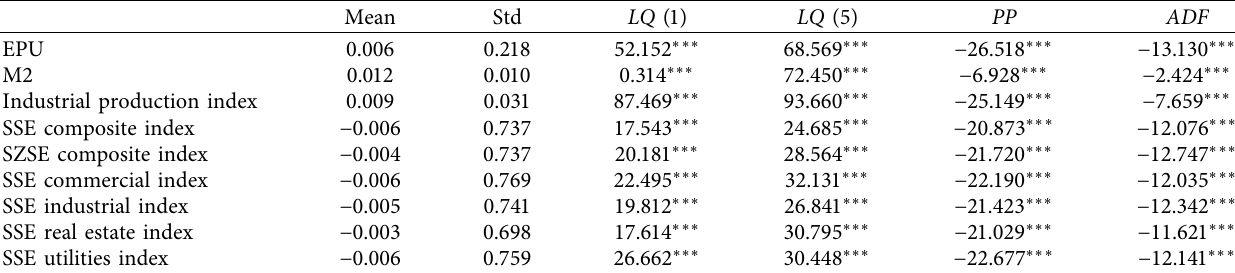
Table 1: Descriptive statistics of sample